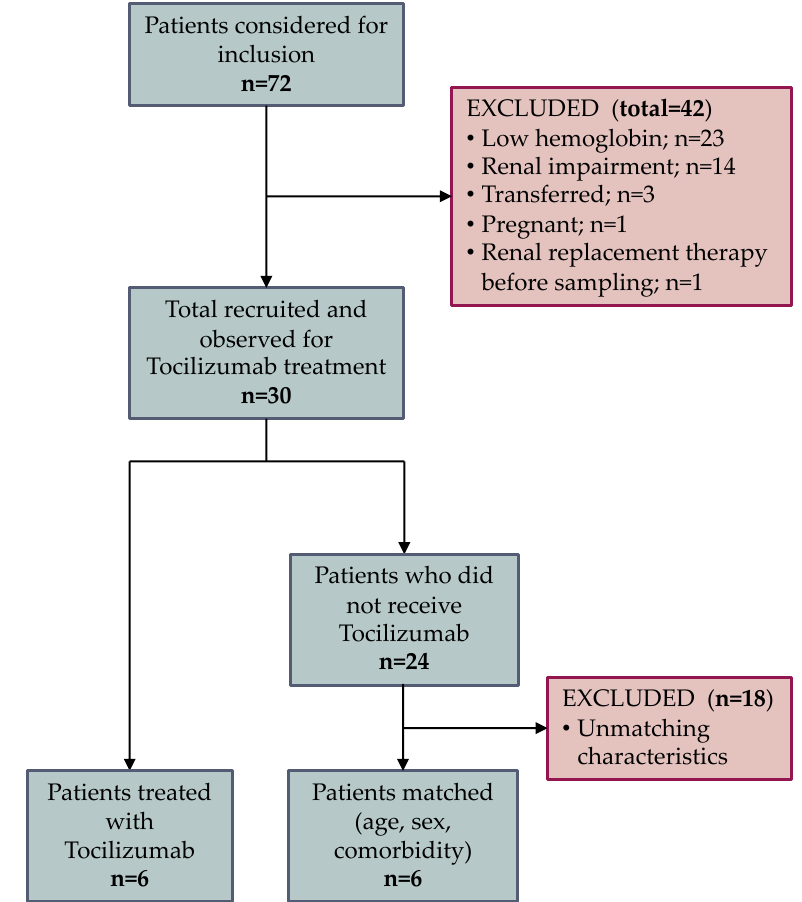
Figure 1. Flow of patients from analysis to inclusion and